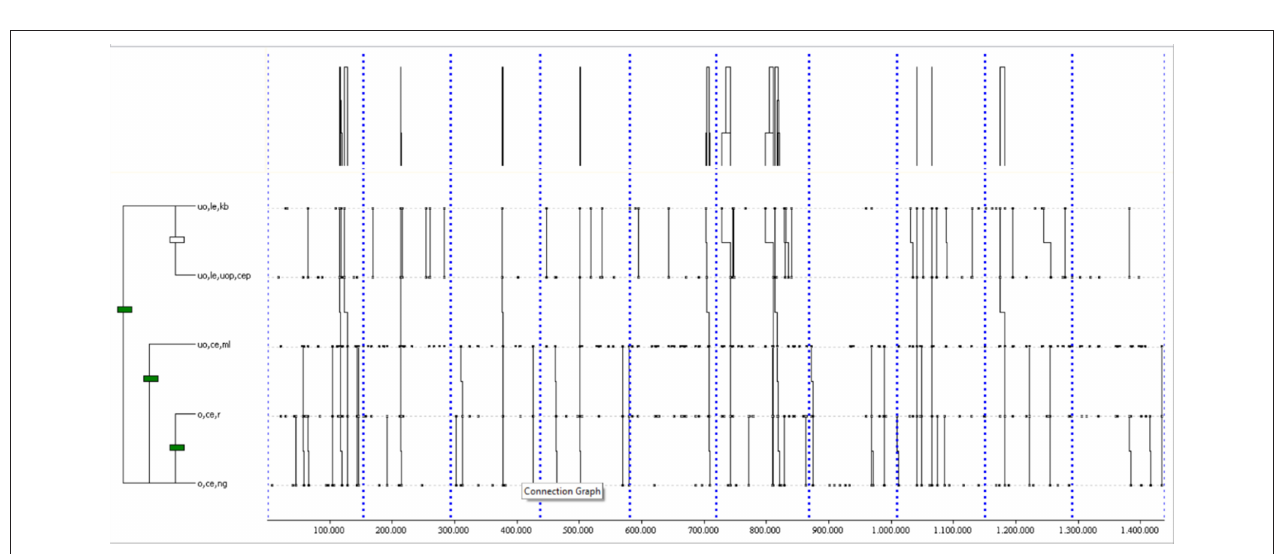
FIGURE 4 | The most complex T-pattern from away matches. It occurred in over 80% of the games analyzed. Events are (1) o,ce,op,cep; (2) uo,ce,ml; (3) uo,ri,ck; (4) uo,ri,uop,cep; and (5) uo,ce,ml.